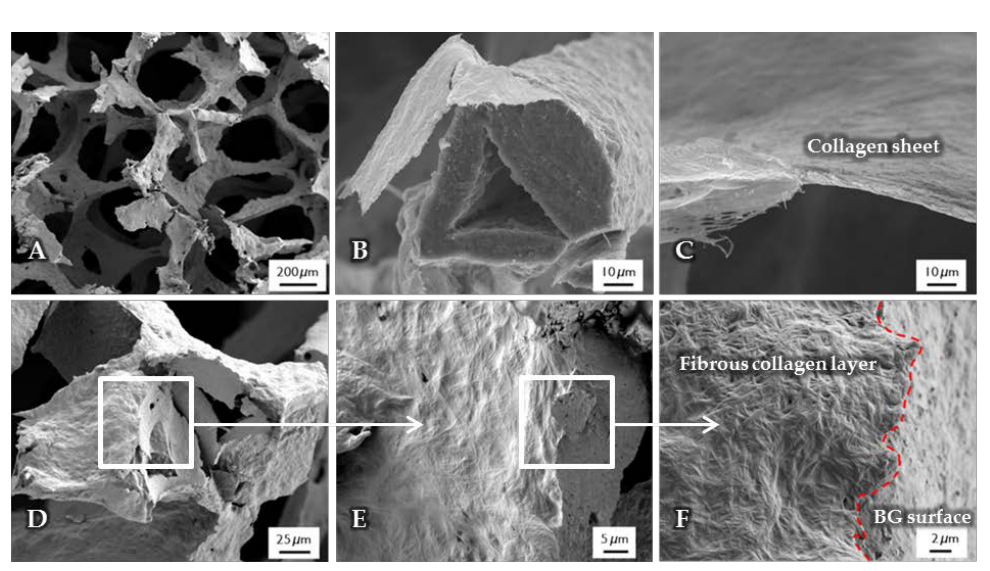
Figure 2. SEM images of uncrosslinked, collagen-coated bioactive glass-based scaffolds. The fibrous collagen layer can be clearly seen ( B ). After the coating process, the overall macroporosity of the scaffold is not affected ( A ). The collagen layer exhibits a thickness of a few micrometers ( C ). At the interface (( D – F ), different magnifications), the rough bioactive glass surface can be clearly distinguished from the fibrous collagen layer.